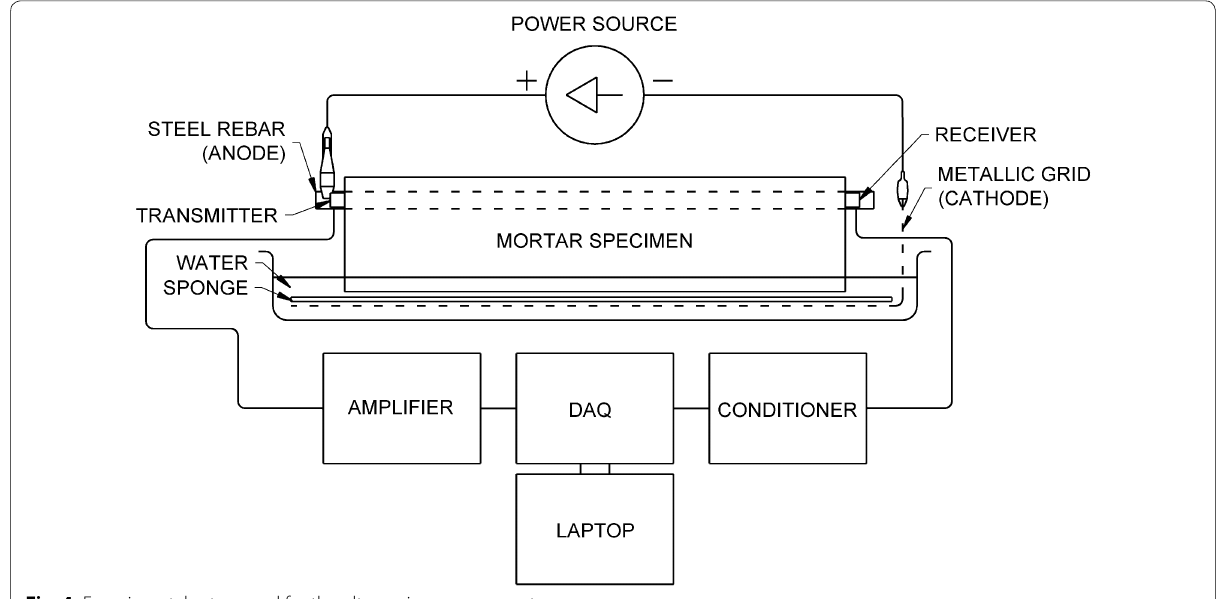
Fig. 4 Experimental setup used for the ultrasonic